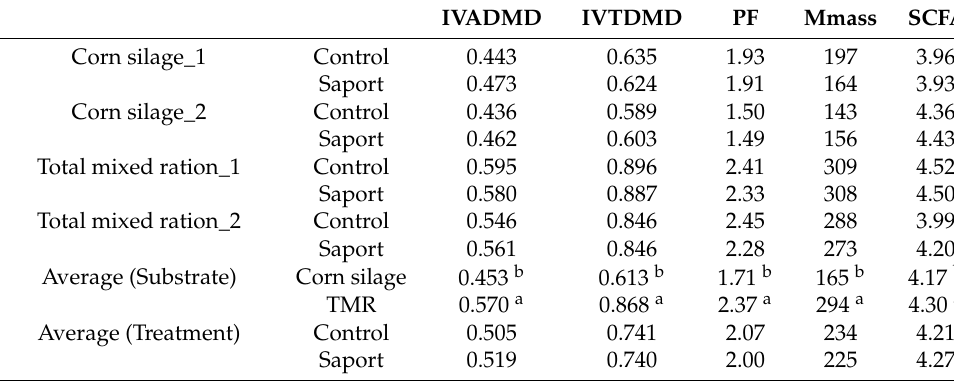
(Table 4). Additionally, the feed additive had no effect ( p > 0.05) on the concentrations of short-chain fatty acids, microbial mass, and partitioning factor. Similar to the trend noted for methane, carbon dioxide, ammonia, and hydrogen sulfite concentrations, TMR also had higher ( p < 0.001) apparent and truly degraded DM, efficiency of microbial production, microbial mass, and short-chain fatty acid concentrations compared to corn silage. Table 4. Effects of treatments on in vitro apparent dry matter digestibility (IVADMD) and in vitro true dry matter digestibility coefficients (IVTDMD), efficiency of microbial production (PF; partitioning factor, mg/mL), microbial mass (Mmass, g/kg DM), and short-chain fatty acids (SCFA, mmol/g DM) of four dairy